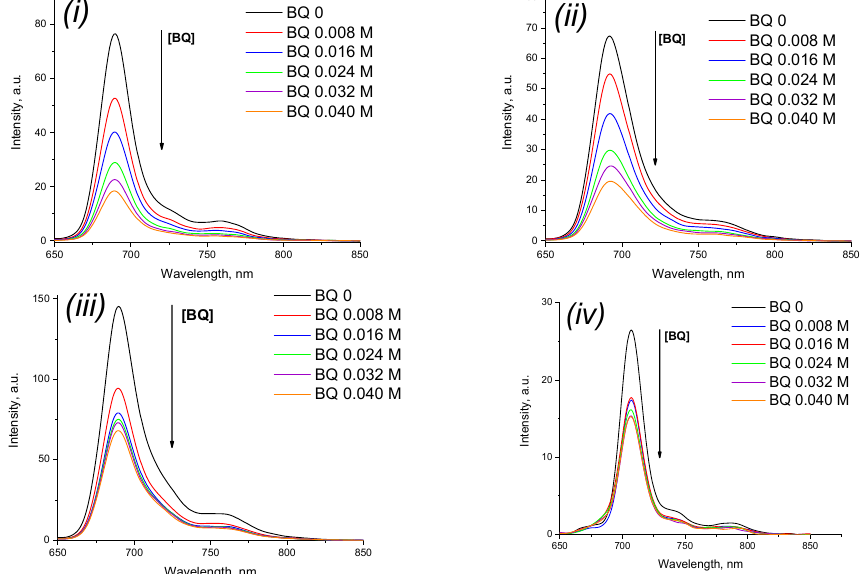
Figure 6. Fluorescence emission spectra changes of 4 ( i ), 5 ( ii ), 6 ( iii ), and 7 ( iv ) upon addition of different concentrations of BQ in CHCl 3 . BQ = 0, 0.008, 0.016, 0.024, 0.032, 0.040 mol/L (note: spectra in acetone and DMF are presented in the Supplementary Materials).